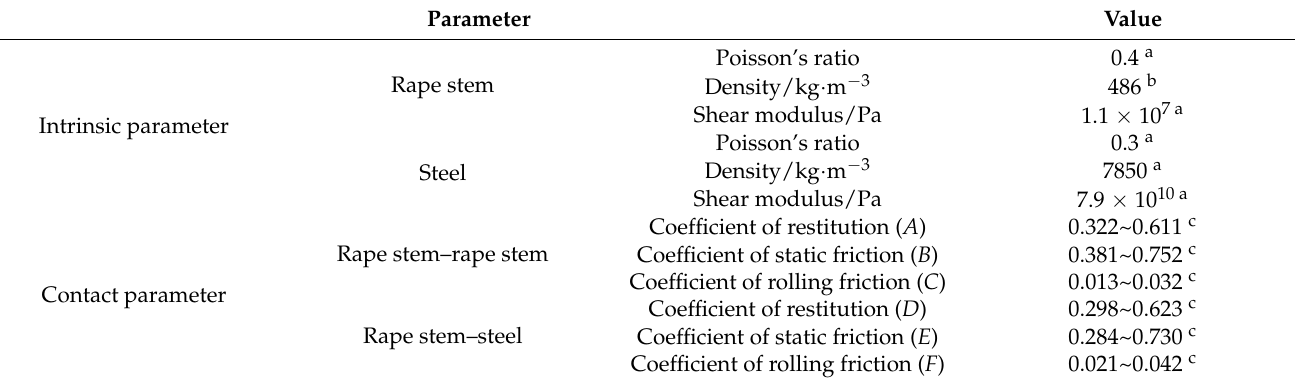
Table 1. Simulation parameter.